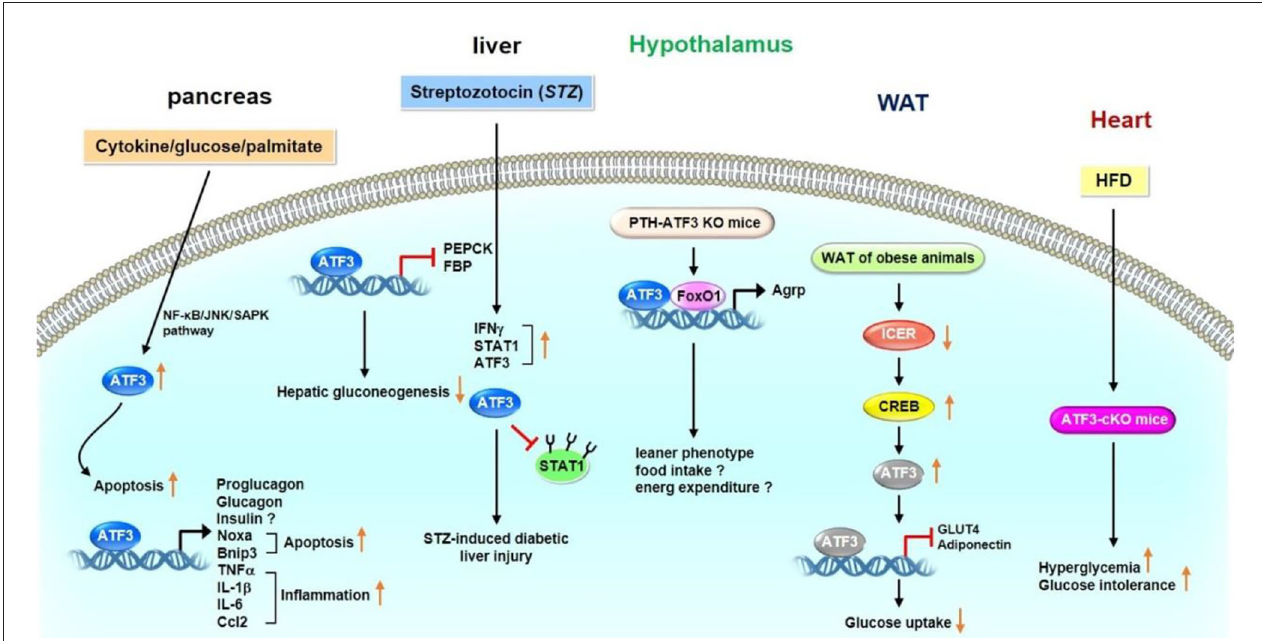
FIGURE 1 | Role of ATF3 in glucose metabolism. ATF3 demonstrated to have different functions in various organs and tissues. In pancreas, ATF3 upregulates the expression levels of peptide hormone genes (proglucagon and glucagon), apoptosis-related genes (Noxa and Bnip3), and inflammation-related genes (TNF α , IL-1 β , IL-6, and Ccl2). In liver, ATF3 decreases the expression levels of gluconeogenic enzymes (PEPCK and FBP) to inhibit gluconeogenesis. In addition, STZ treatment upregulates the expression levels of IFN γ , STAT1 and ATF3 in diabetic liver injury. ATF3 stabilized STAT1 by blocking ubiquitination and proteasomal degradation of STAT1 in hepatocytes. Loss of hypothalamic ATF3 decreases Agrp expression. These mice displayed a leaner phenotype possible as a result of decreased food intake and enhanced energy expenditure. ATF3 interacts with FoxO1 on Agrp promoter to upregulate its transcription. In adipose tissue, ATF3 may result in insulin resistance by downregulating Glut4 and adiponectin expression. In heart, HFD-fed ATF3-cKO mice show increased hyperglycemia and glucose intolerance. These observations indicate that ATF3 plays an important role in regulating glucose metabolism in various organs and